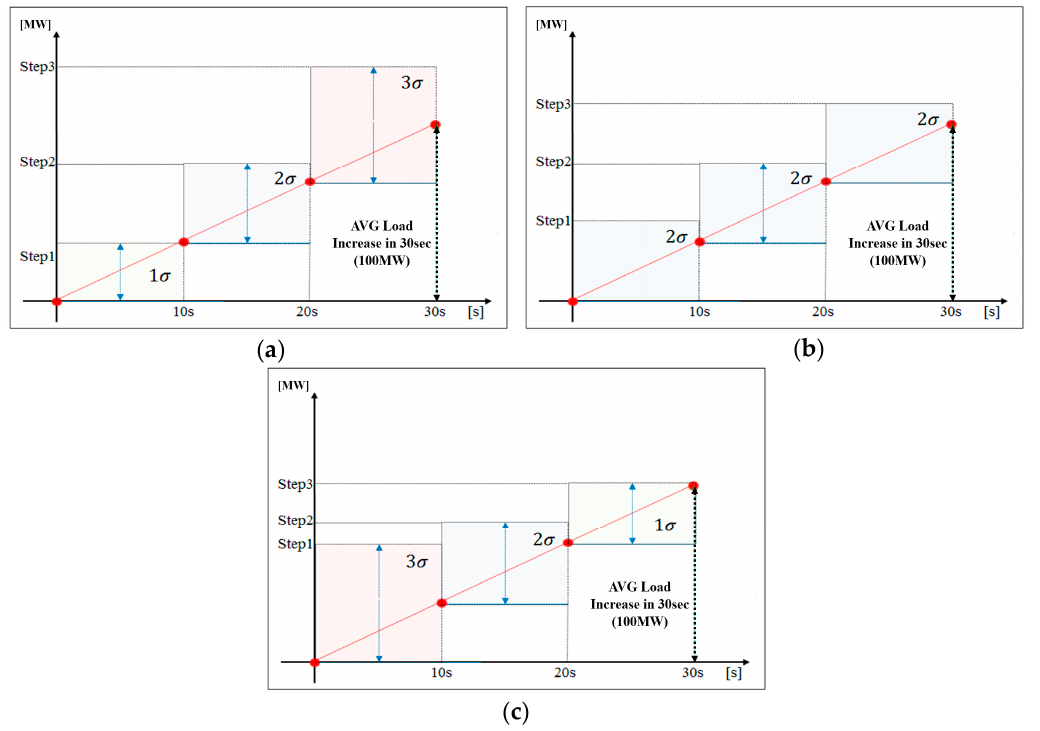
Figure 31. Simulation profile for process change: ( a ) Original process; ( b ) Load re-distribution; ( c ) Load re-allocation.